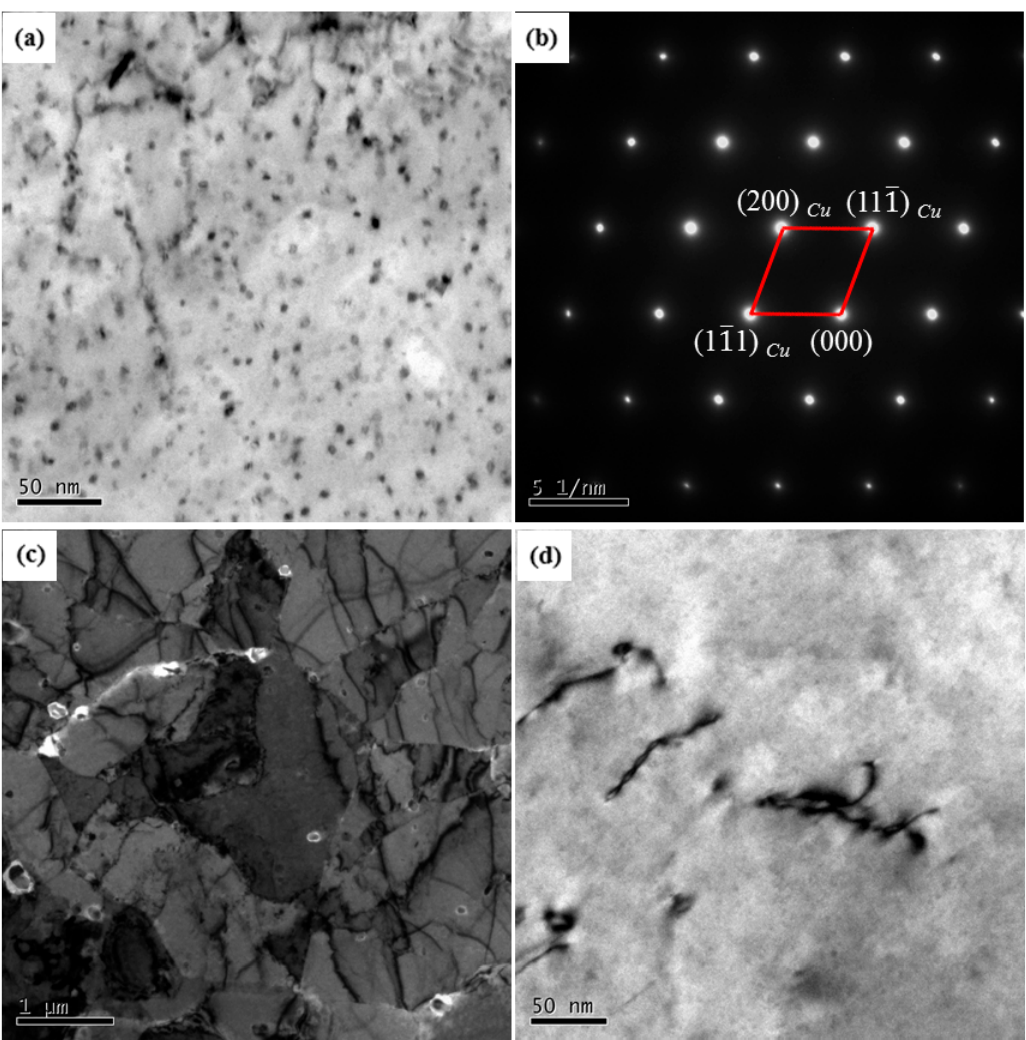
Figure 7. TEM micrographs of ( a ) the BM showing precipitates and exhibiting Moiré fringes; ( b ) the corresponding SAED pattern of BM; ( c ) shows that the small recrystallized grains of the NZ contain sub-grains; and ( d ) no precipitates showing in fine grains of NZ and the corresponding SAED pattern.